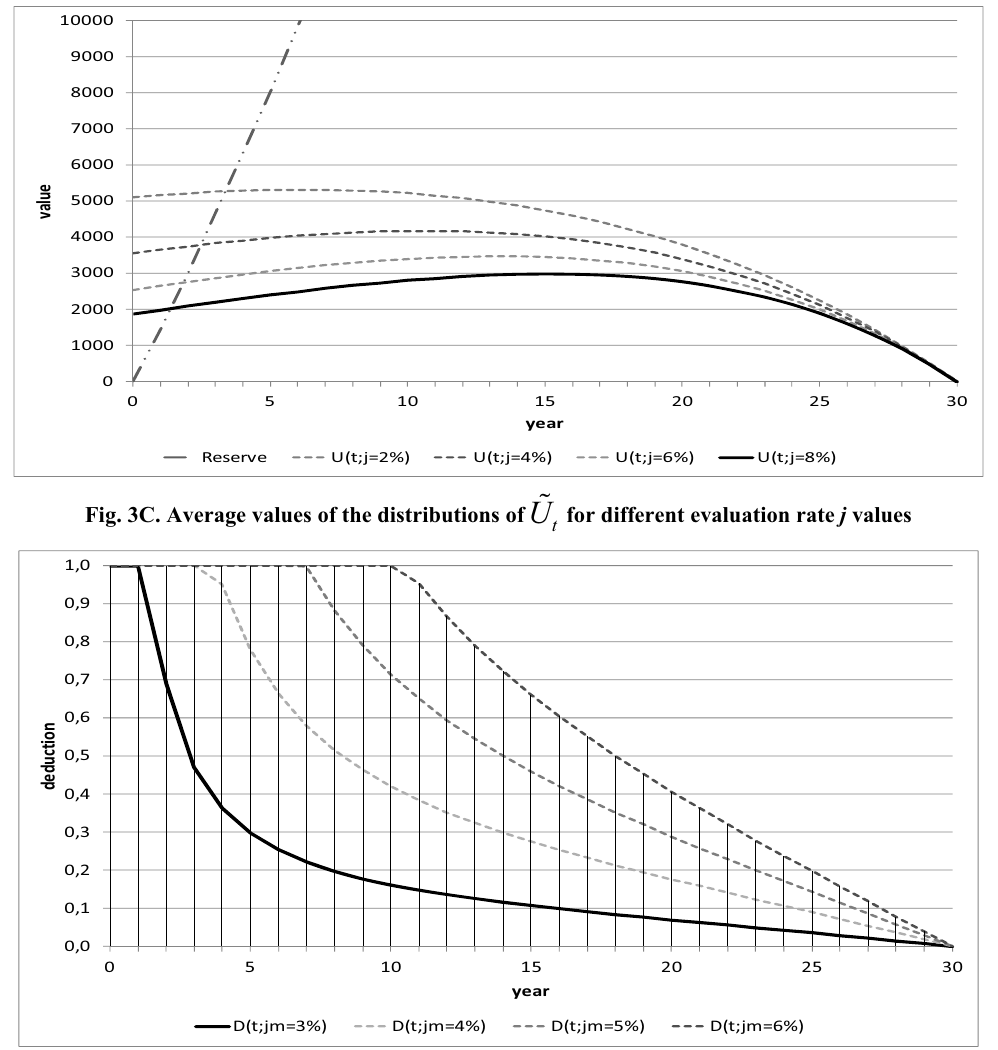
Fig. 4C. Comparative deduction D ( t ; 1) for different values of the yield average rate, j m